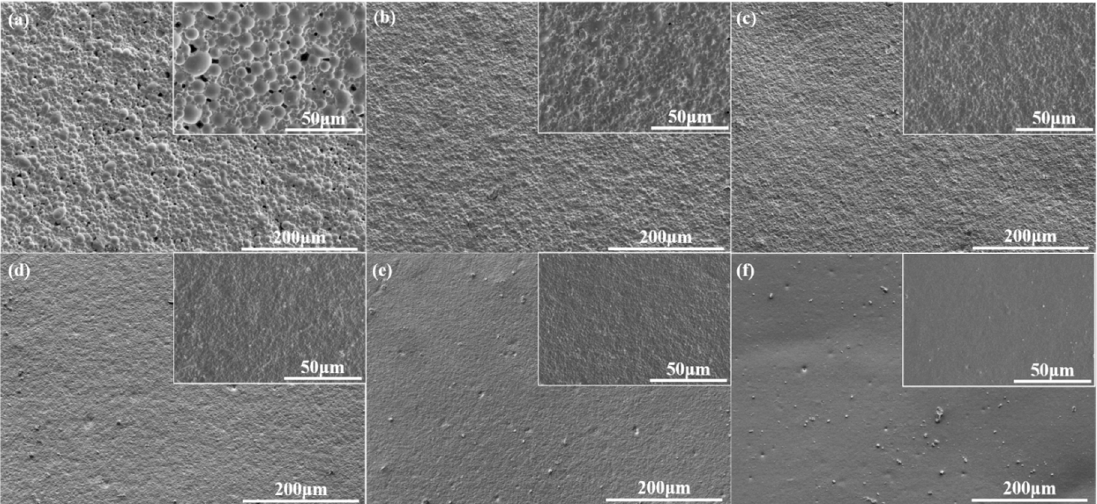
Figure 3. SEM micrographs of WPU-A films with different AAS contents: ( a ) 0.5%; ( b ) 0.6%; ( c ) 0.7%;